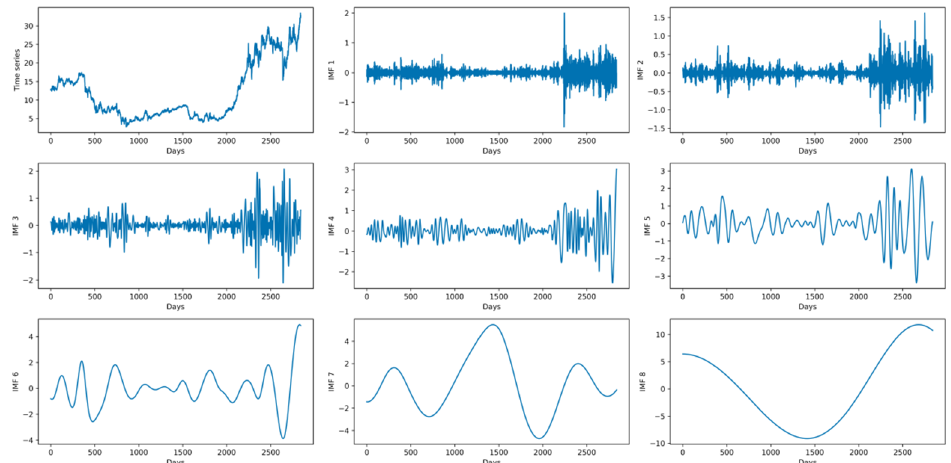
Figure 3. Original time series and the 8 IMFs of the EMD of the daily spot prices of CO 2 .